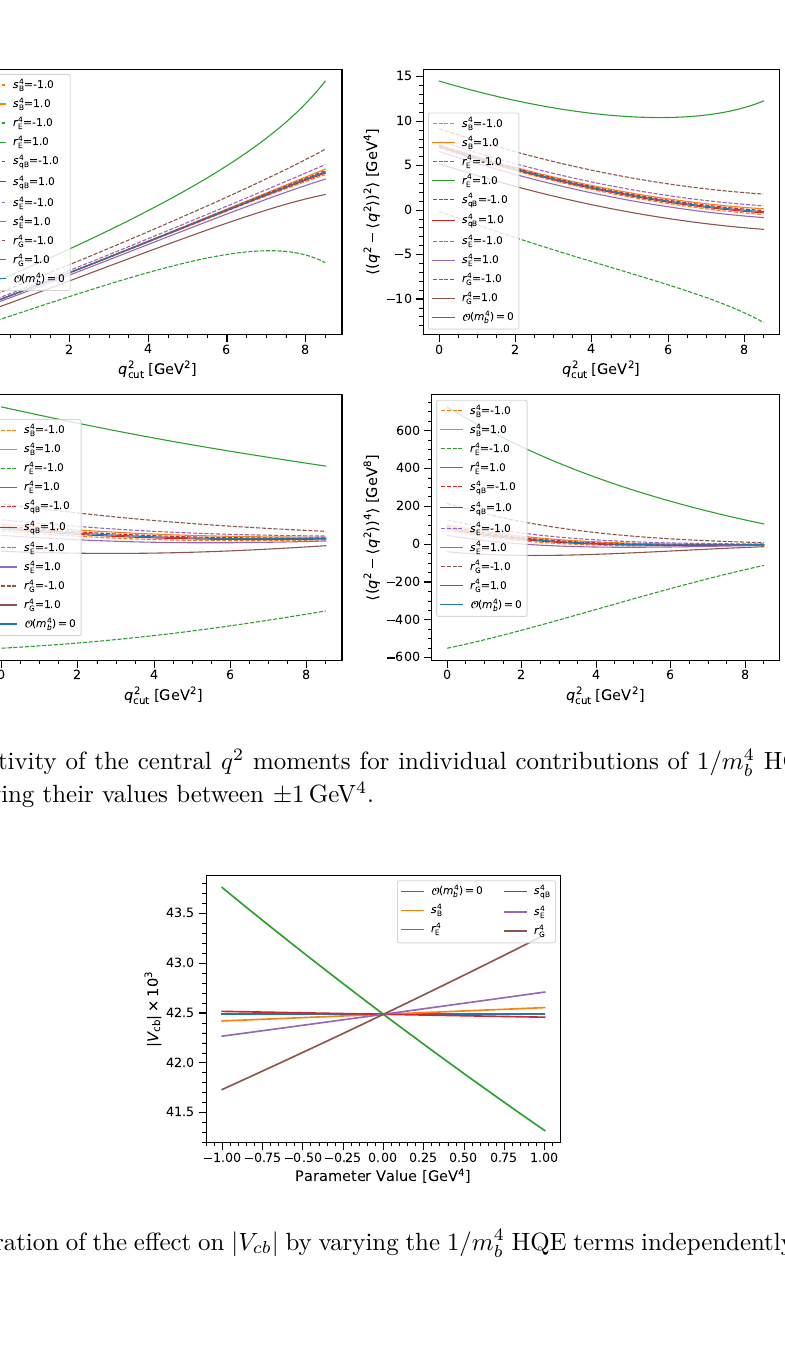
Figure 3 . Illustration of the effect on | V cb | by varying the 1 /m 4 ± 1 . 0 GeV 4